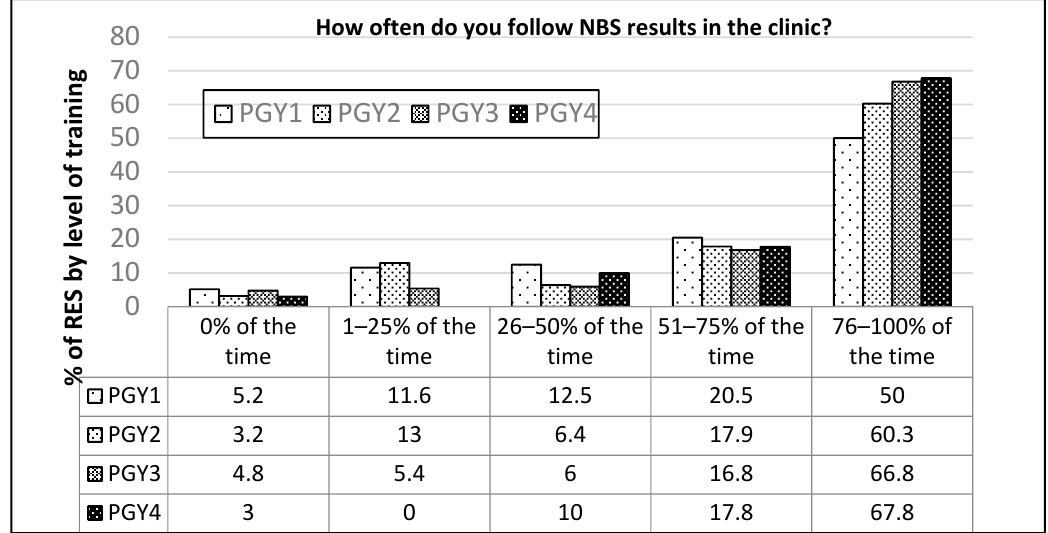
Figure 3. Follow up of NBS results in clinic by training level. Higher level trainees (PGY3 and PGY4) follow results in clinic more often than lower level trainees (PGY1 + PGY2) ( p = 0.0027).